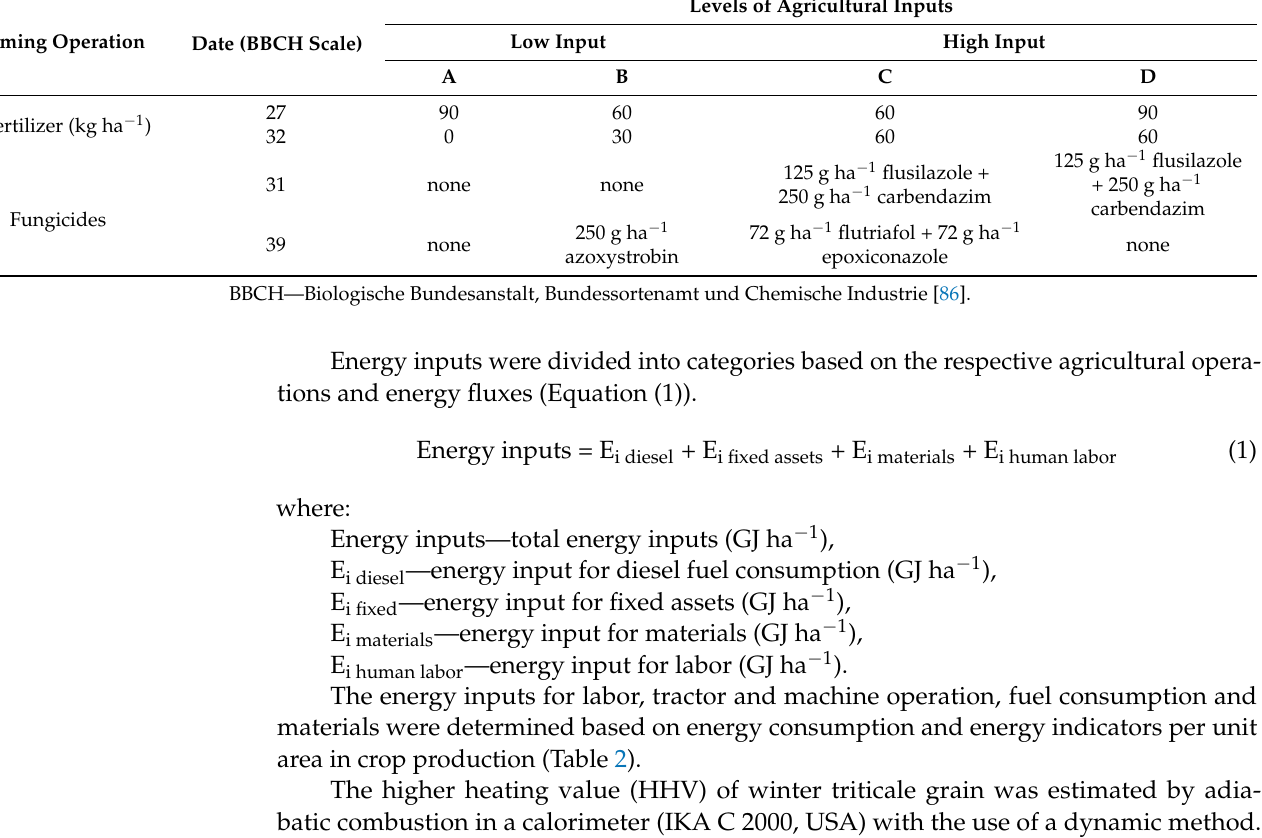
Farming Operation Date (BBCH Scale)